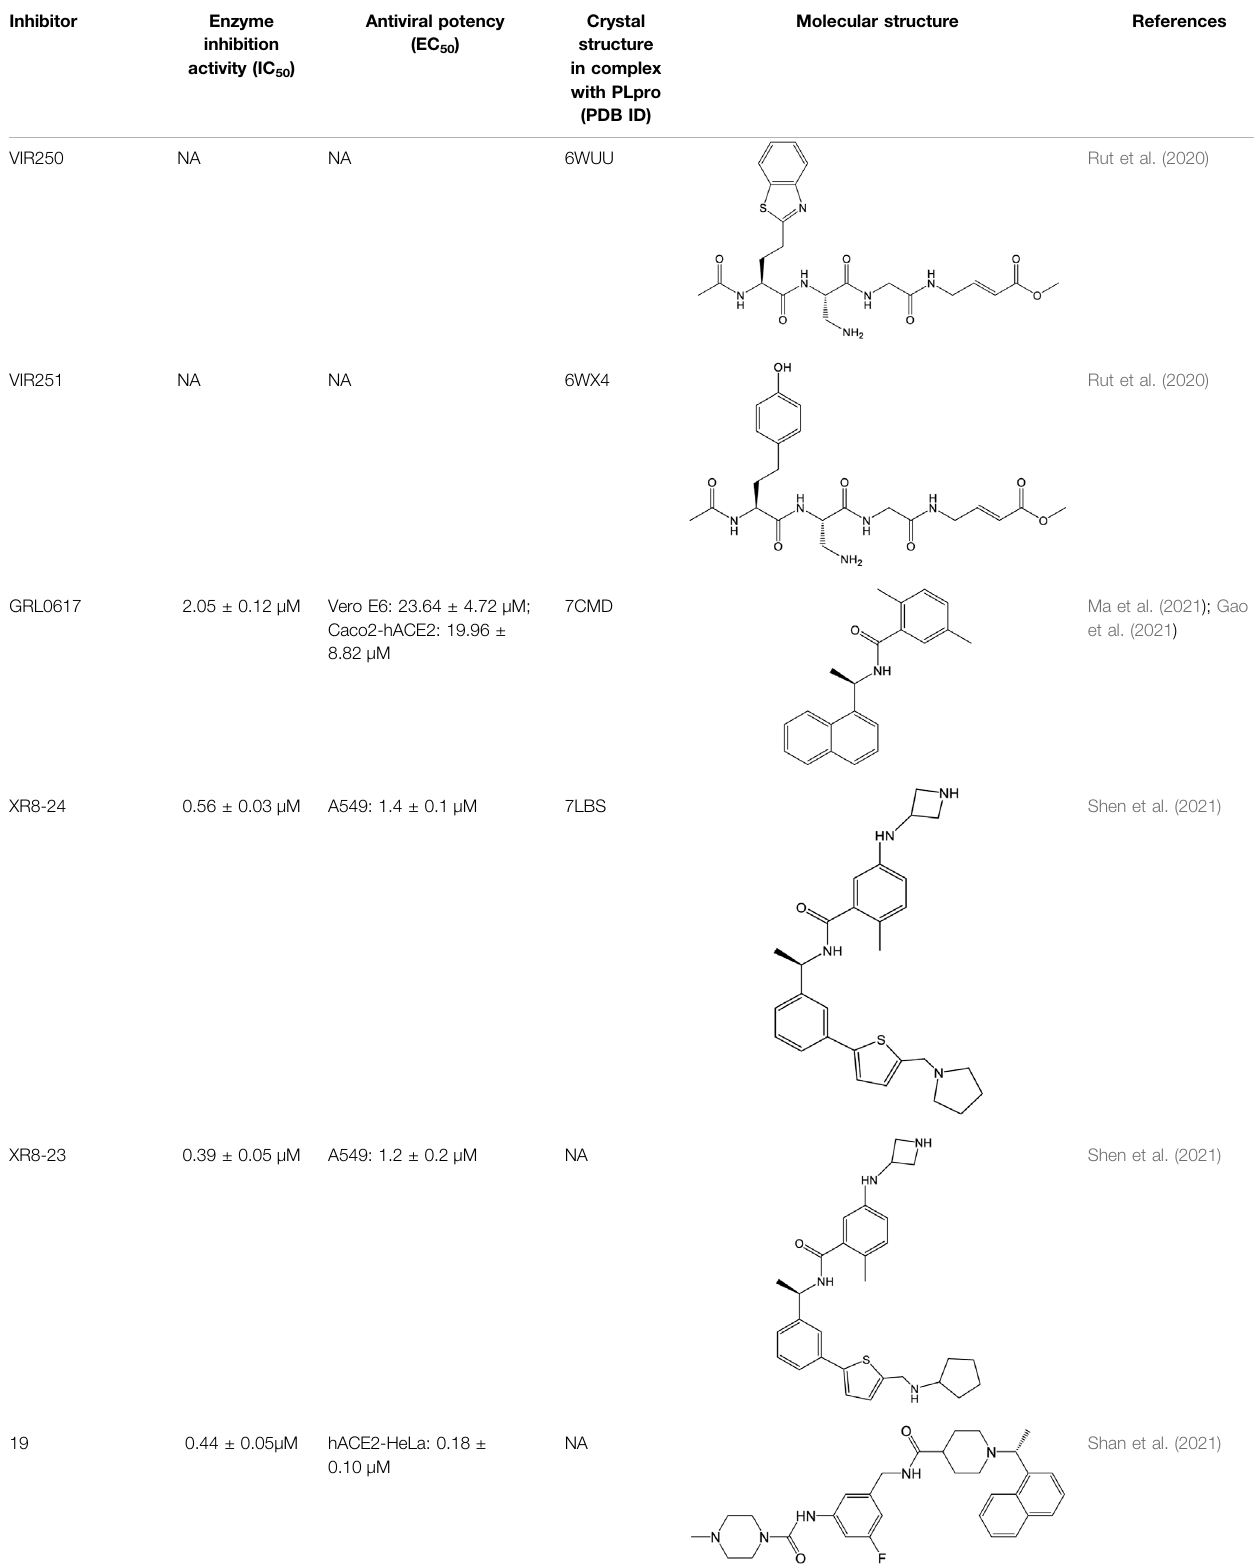
TABLE 1 | Representative potential inhibitors of SARS-CoV-2